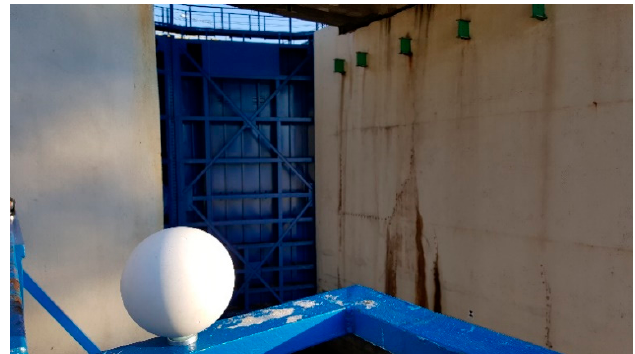
Figure 7 . Representation of the surveying point during the tests.